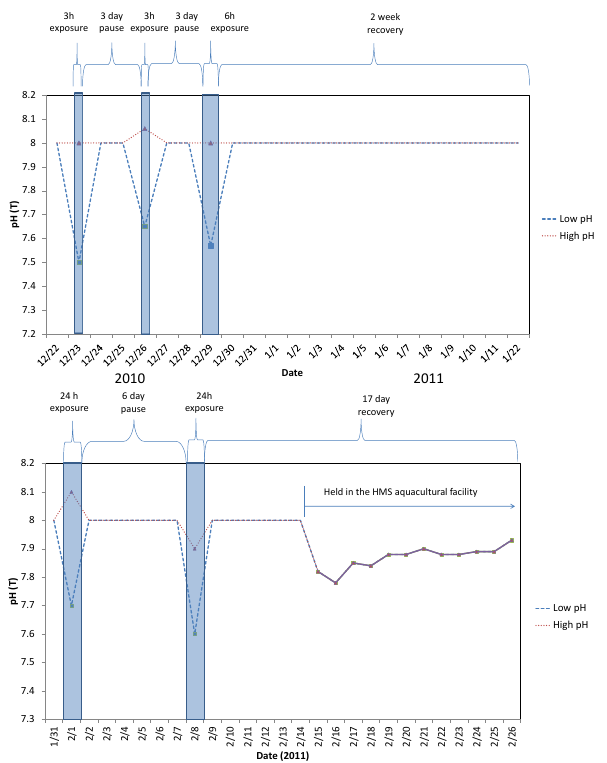
Fig. 1. Diagram describing treatment exposure and recovery sched- ule and pH values changing for (a) Experiment I and (b) Experiment II. Red triangle (high pH) and blue square (low pH) dots represent the pH values measured using a pH meter, and dashed line repre- sents the assumed pH value throughout the